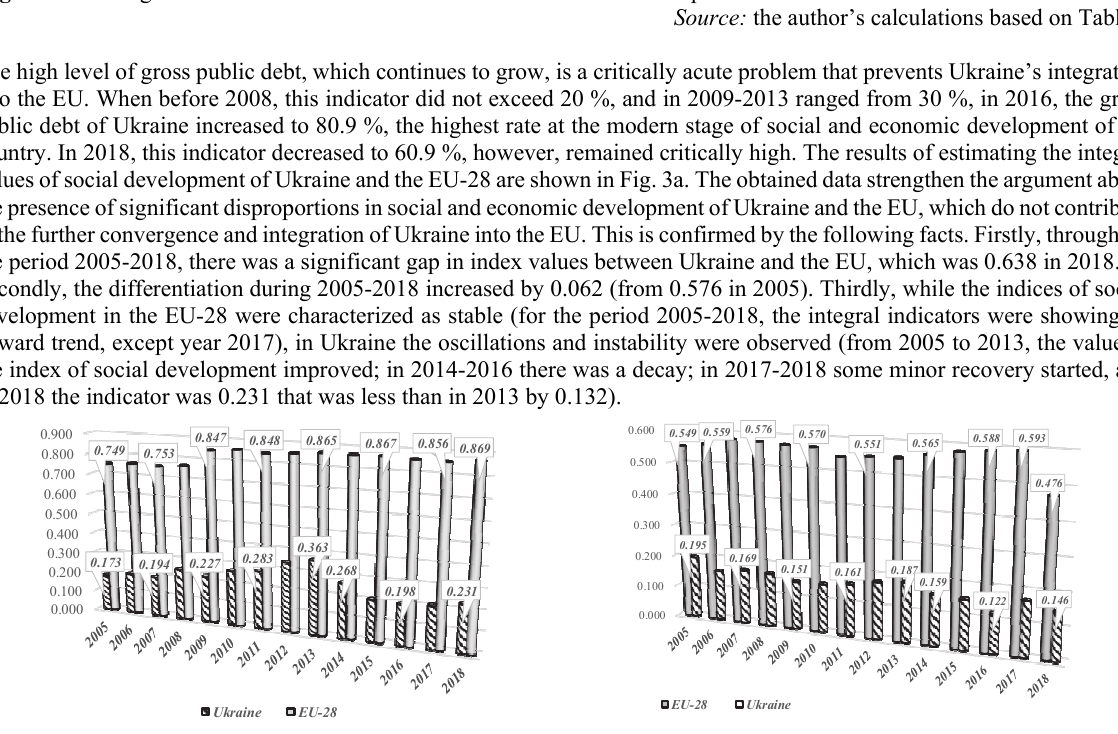
Fig. 2 . The average annual rate of Ukraine’s deviations of economic development indicators from the EU-28 for 2005-2018